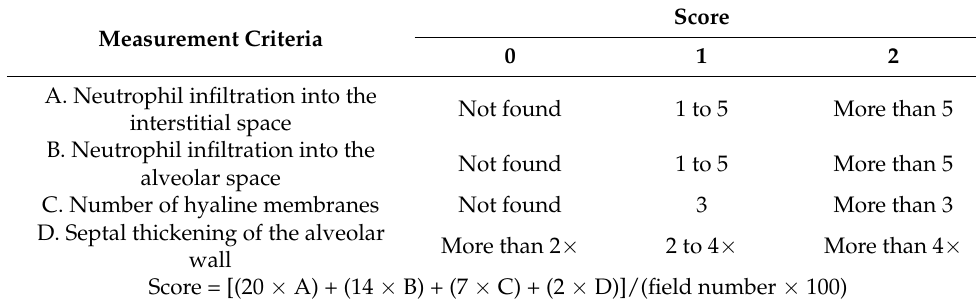
Table 1. Lung injury scoring index [37]. Measurement